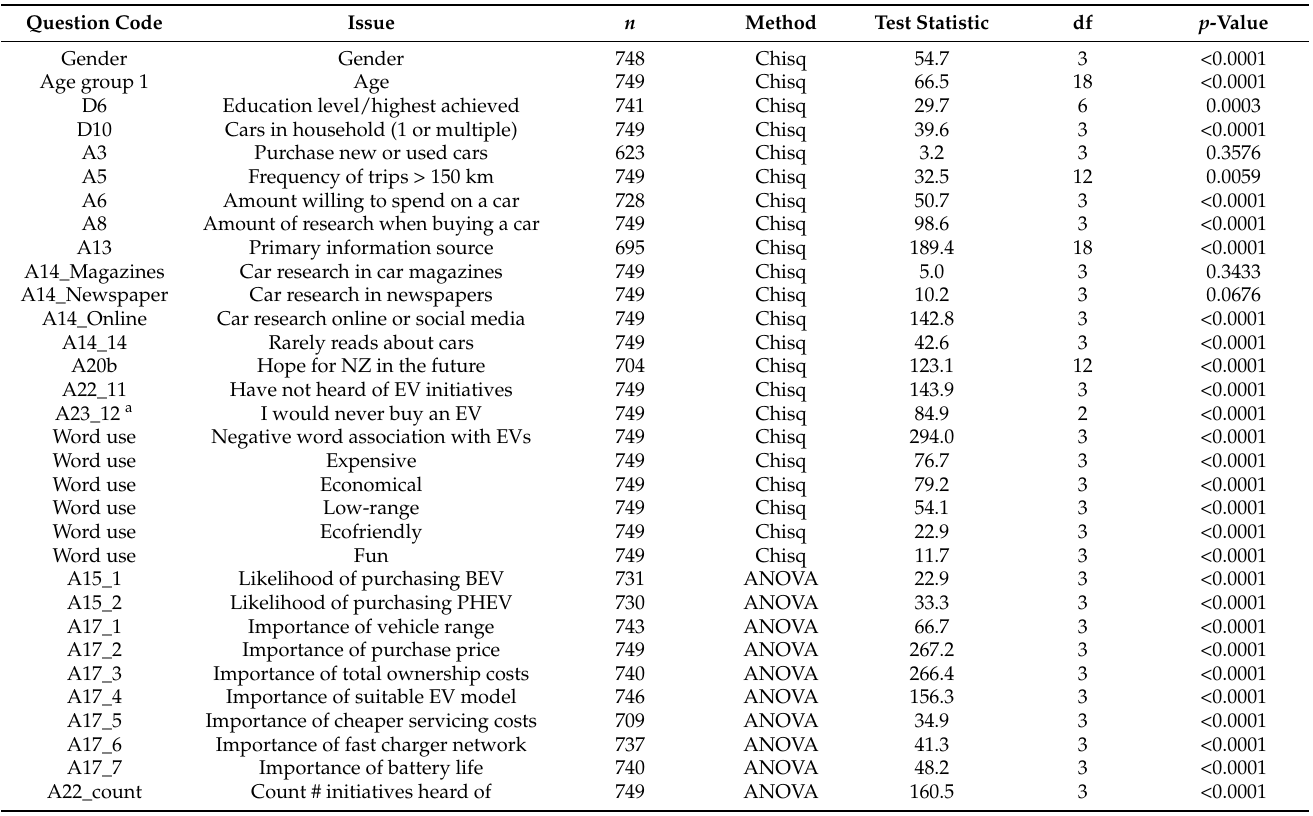
Table 2. Driver Type analysis results: Pearson’s Chi-squared tests and ANOVAs for the questions of interest compared to ‘Driver Type’ (Question A16). N is sample numbers remaining after filtering, which is a method that is used with test statistics, that is, chi-squared test statistics for chi-squared tests and likelihood ratio test statistics for ANOVAs. Df is the degrees of freedom and ‘ p -value’ refers to the p -values after using a Holm adjustment (Holm, 1979) [45] to account for multiple hypothesis testing. Table S6 provides the full wording for each question.